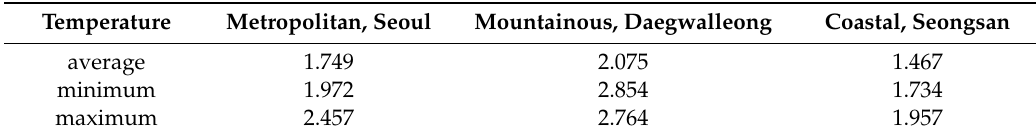
Table 18. Average of daily temperature absolute di ff